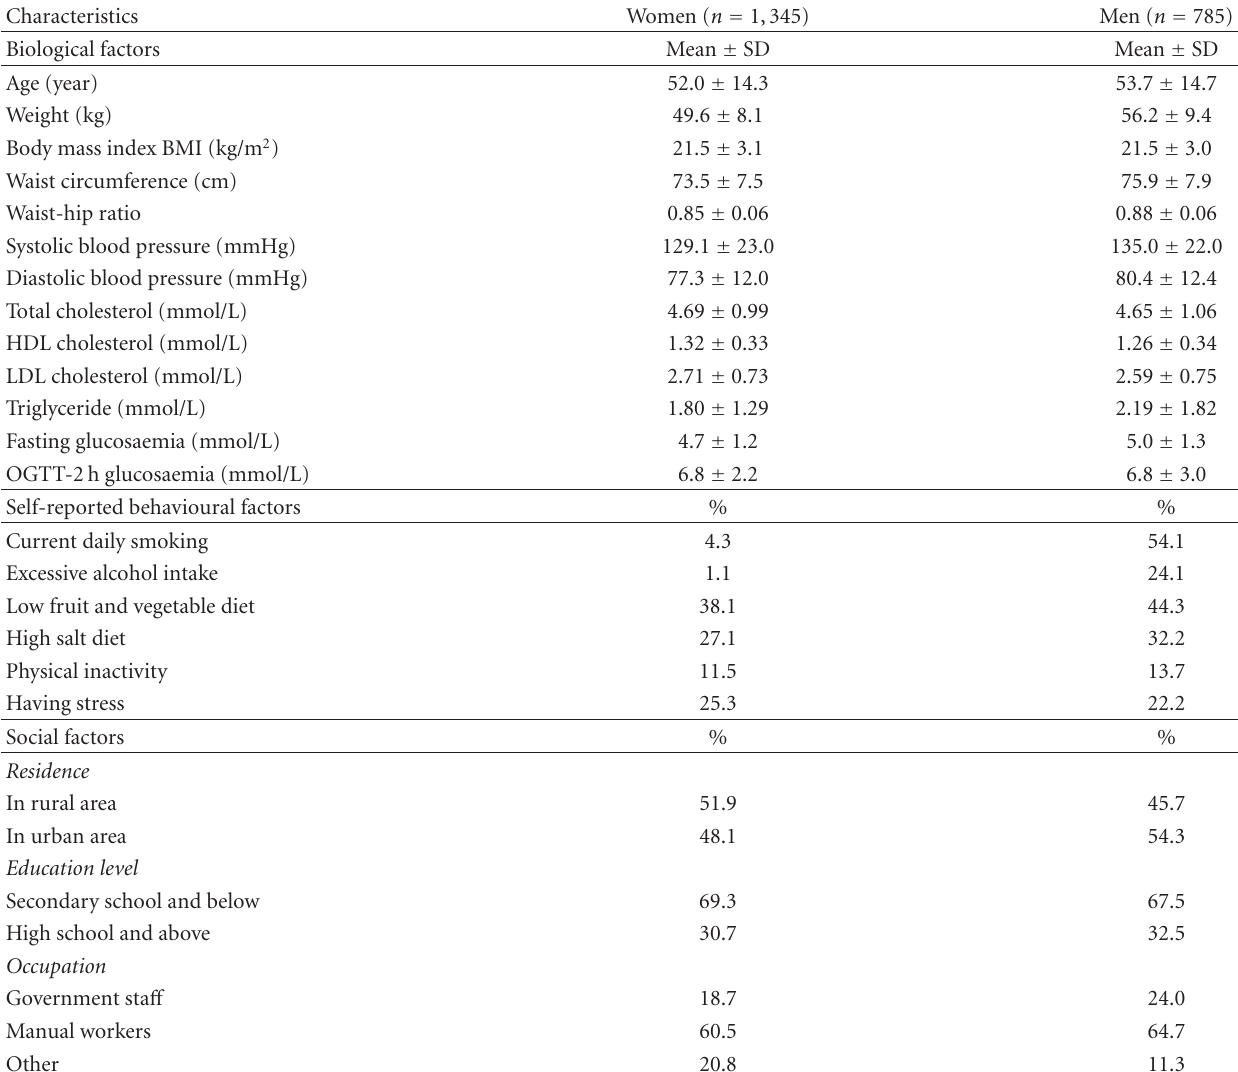
Table 1: General characteristics of the study